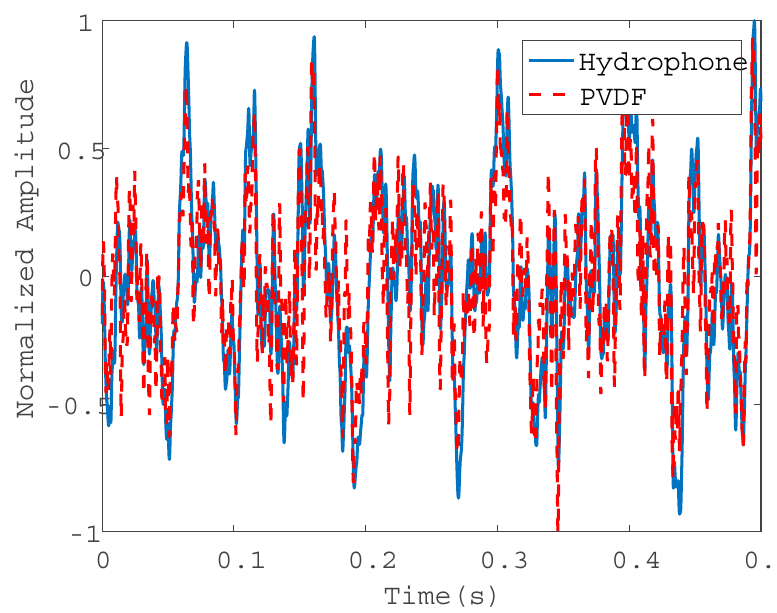
Figure 13. Time-domain leak signals collected by the PVDF wire sensor of 6t and hydrophone at 0.9 m (in-water case).